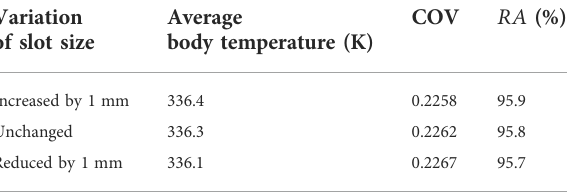
FIGURE 9 Variation in the energy-absorption rate when changing the imaginary part of the relative